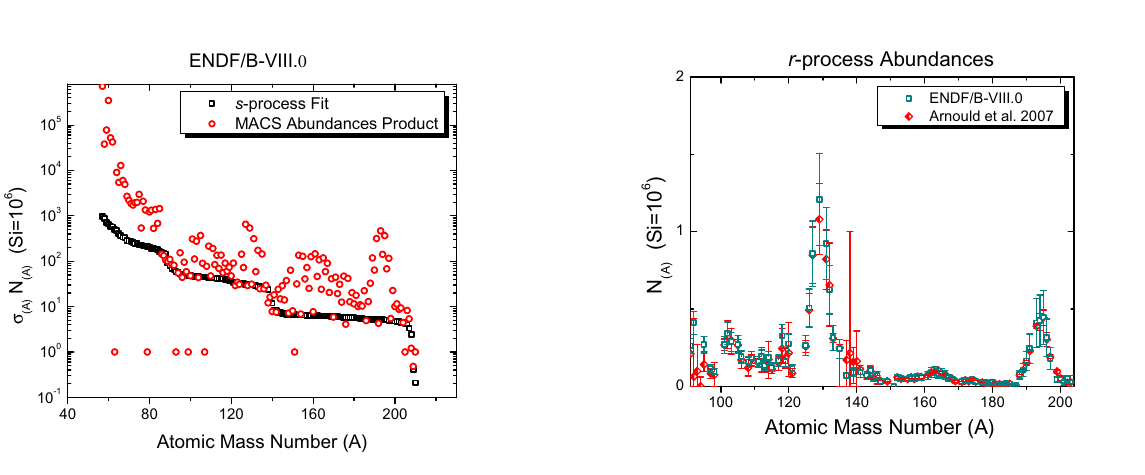
Figure 1. ENDF / B-VIII.0 neutron capture MACS at kT = 30 keV times the solar system abundance and s -process fitted values as function of the atomic mass number. The solar system isotope abundances are taken from Ref. [35].